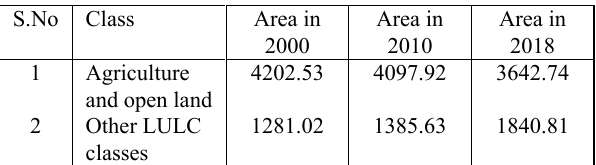
Figure 4. Allahabad district LULC map of year 2010